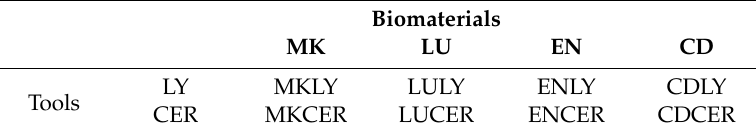
Table 3. Tool-biomaterial couples codes.